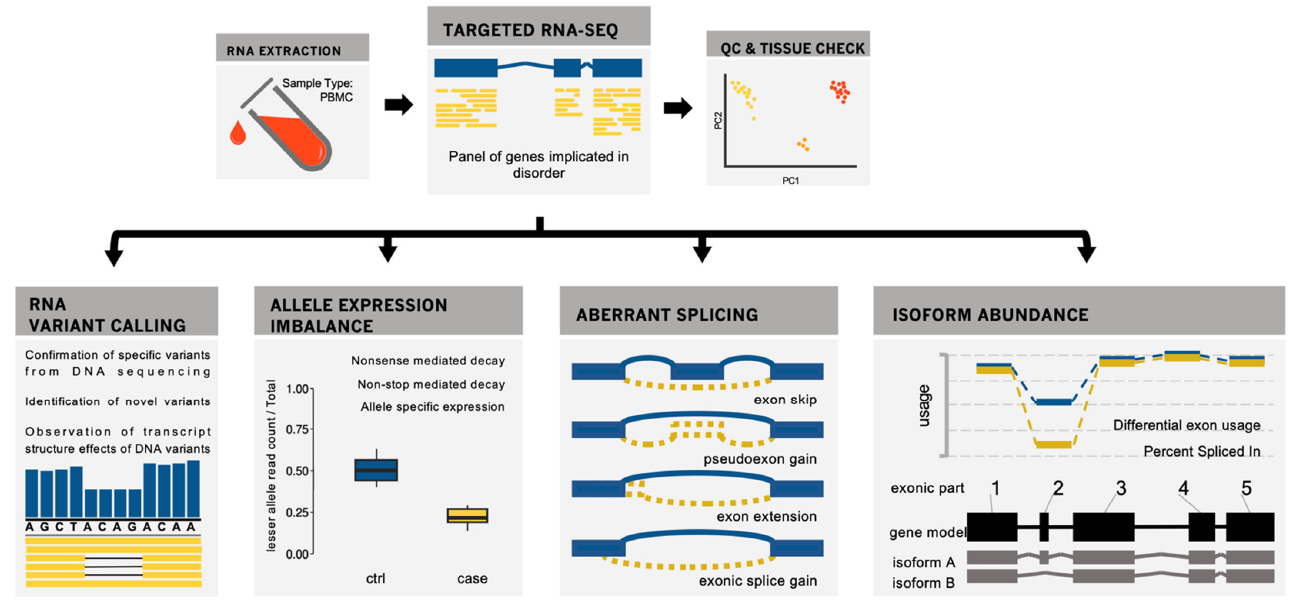
Figure 1. An overview to the RNAseq analysis approach. The visuals in this figure are representative of concepts and do not show data from this study. PBMCs are extracted from whole blood and sequenced using a targeted gene panel. After QC, variants are called in the RNA to confirm variants from exome sequencing and identify variants not captured in exome sequencing. Allele expression imbalance, aberrant splicing, and isoform abundance are analyzed in tandem with called variants to provide a more complete picture of the functional effects of variants on mRNA structure.